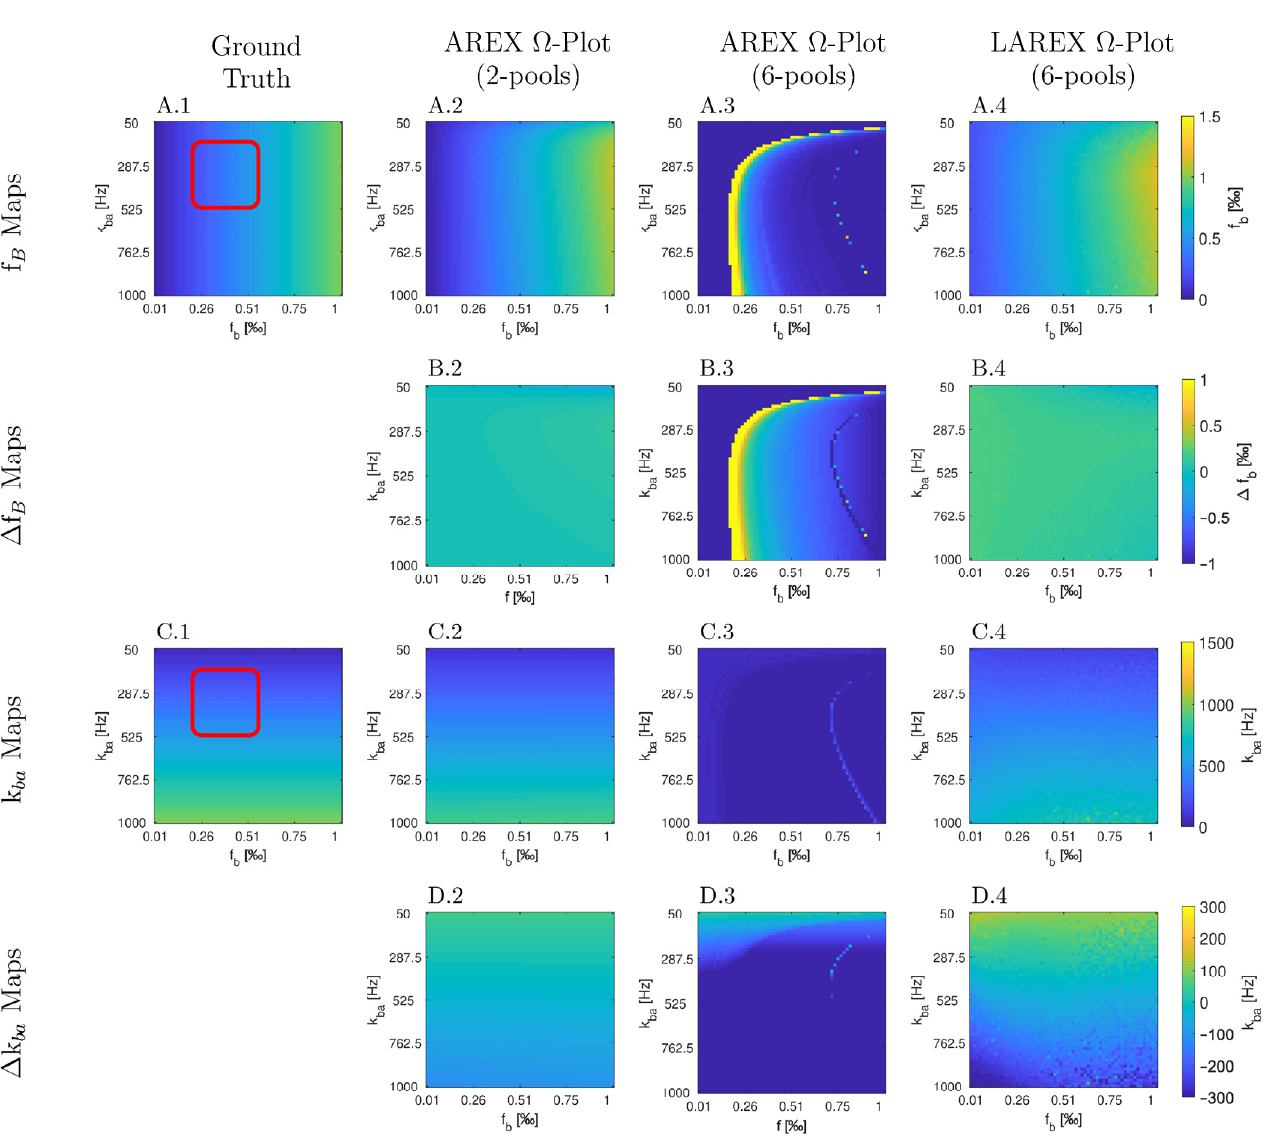
Figure A4. In silico Appendix Study 4—Creatine qCEST analyses of human brain. Parameter maps ( A , C ) and color-coded error maps ( B , D ) for fractional Creatine concentrations f b and Creatine exchange rates k ba as a function of f b and k ba . The study was performed using a 6-pool system and a field strength of 7 Tesla. The parameters of the exchanging proton pools were: Water (T 1 = 2000 ms, T 2 = 115 ms, and ∆ = 0 ppm); Creatine (T 1 = 1000 ms, T 2 = 10 ms, f = variable 0.00001–0.001, k sw = variable 50–1000 Hz and ∆ = 1.8); Amide (T 1 = 1000 ms, T 2 = 33 ms, f = 0.0008, k ba = 30 and ∆ = 3.5); Glutamate (T ∆ s = 3.0); Myo-inositol 1 = 1000 ms, T 2 = 10 ms, f s = 0.000125, k sw = 2000 and (T 1 = 1000 ms, T 2 = 10 ms, f = 0.0007, k ba = 600 and ∆ = 0.6); NOE (T 1 = 1000 ms, T 2 = 0.01 ms, f = 0.0795, k ba = 10 and ∆ = − 2.4), and were based on the results of Sing et al. [69]. Furthermore, analogous to the in silico, in situ, and in vivo experiments, the same MR parameters (TR = 2500 ms, TE = 3.5 ms) and presaturation parameters (n p = 40, t p = 100 ms, t d = 100 ms, presaturation pulse shape = Gaussian, ∆ ω = 5 ppm) were